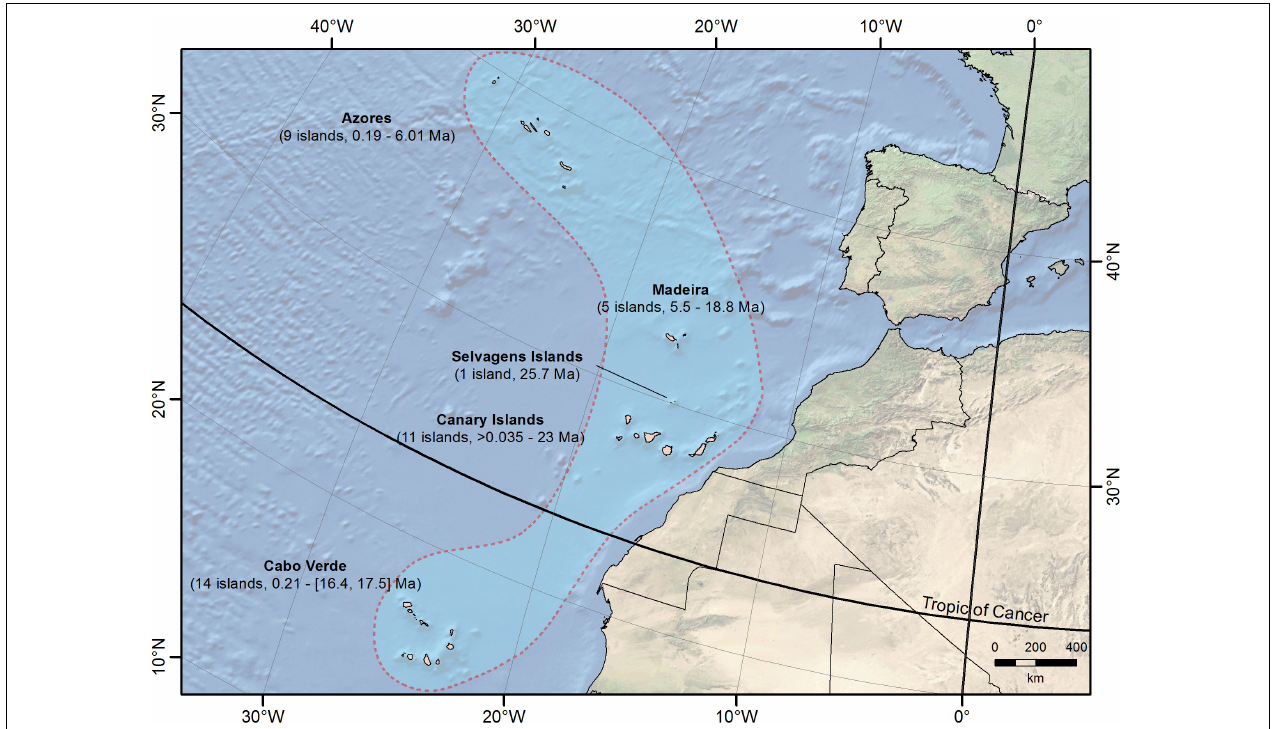
FIGURE 1 | Geographical location of the Macaronesian archipelagos, with indication of the number of islands and their geological age (only islets > 1 km 2 were included; see Table 1